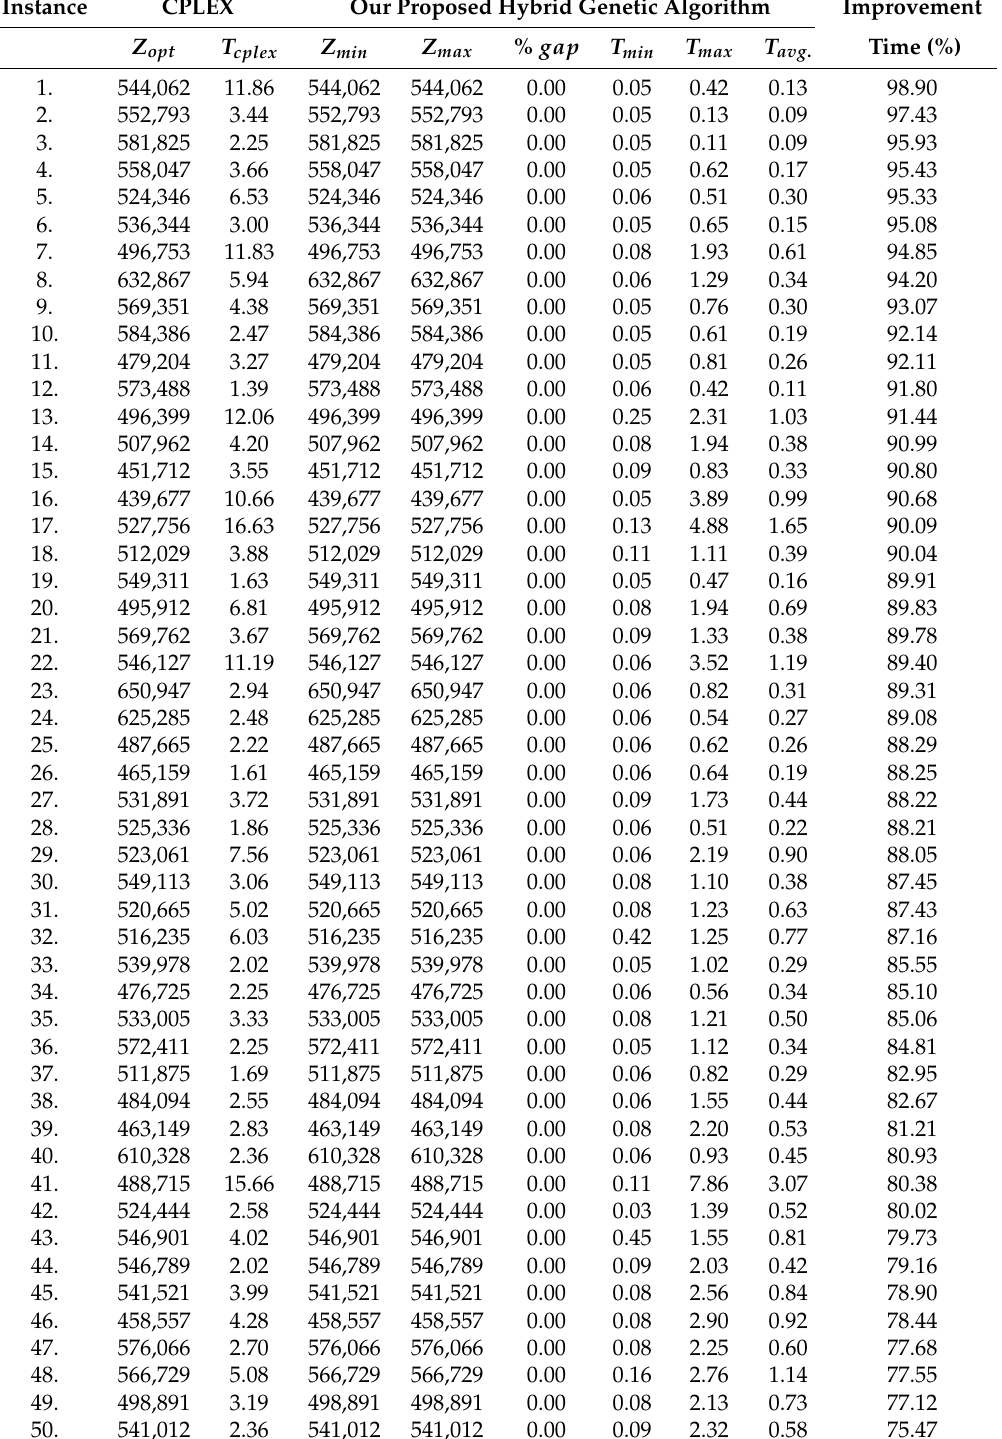
Table 2. Computational results achieved in the case of medium sized